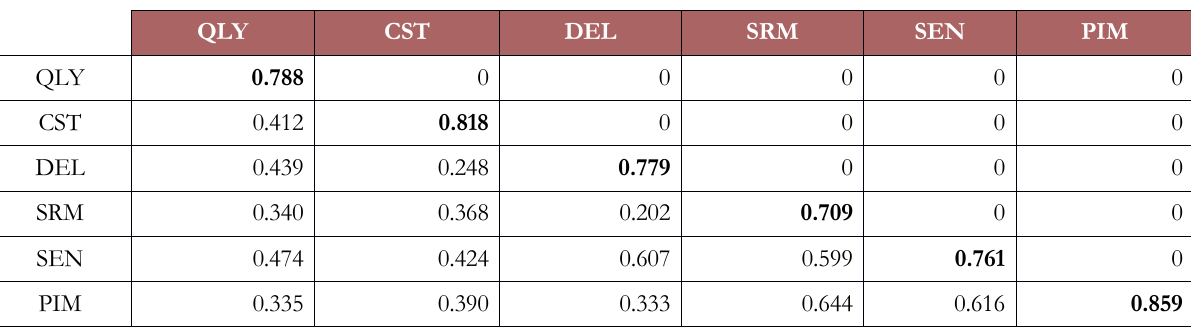
Table 5. Latent Variable Correlations and discriminant validity